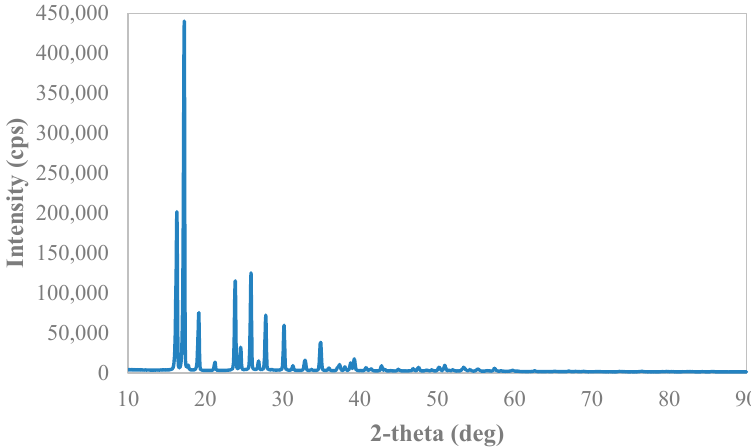
Figure A5. X-ray diffraction spectra of benzoic acid as original sample.